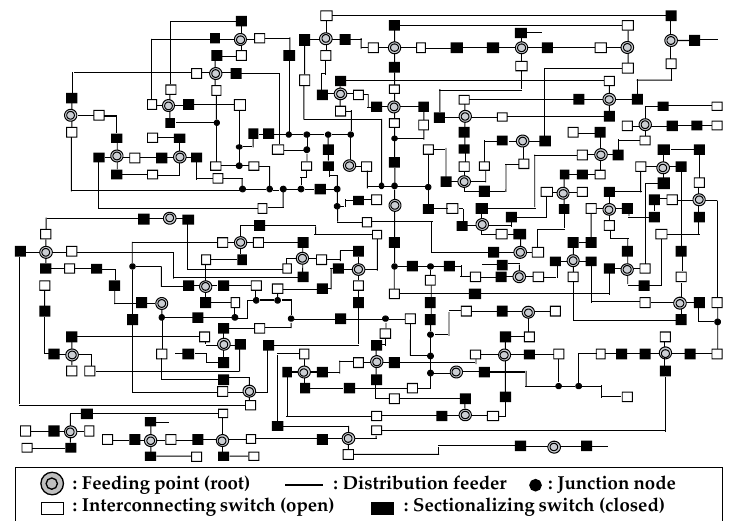
Figure 5. Numerical simulation model.